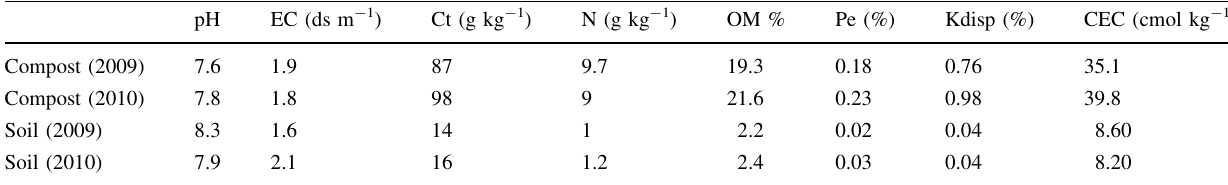
Table 1 Composition of soil and compost used during the